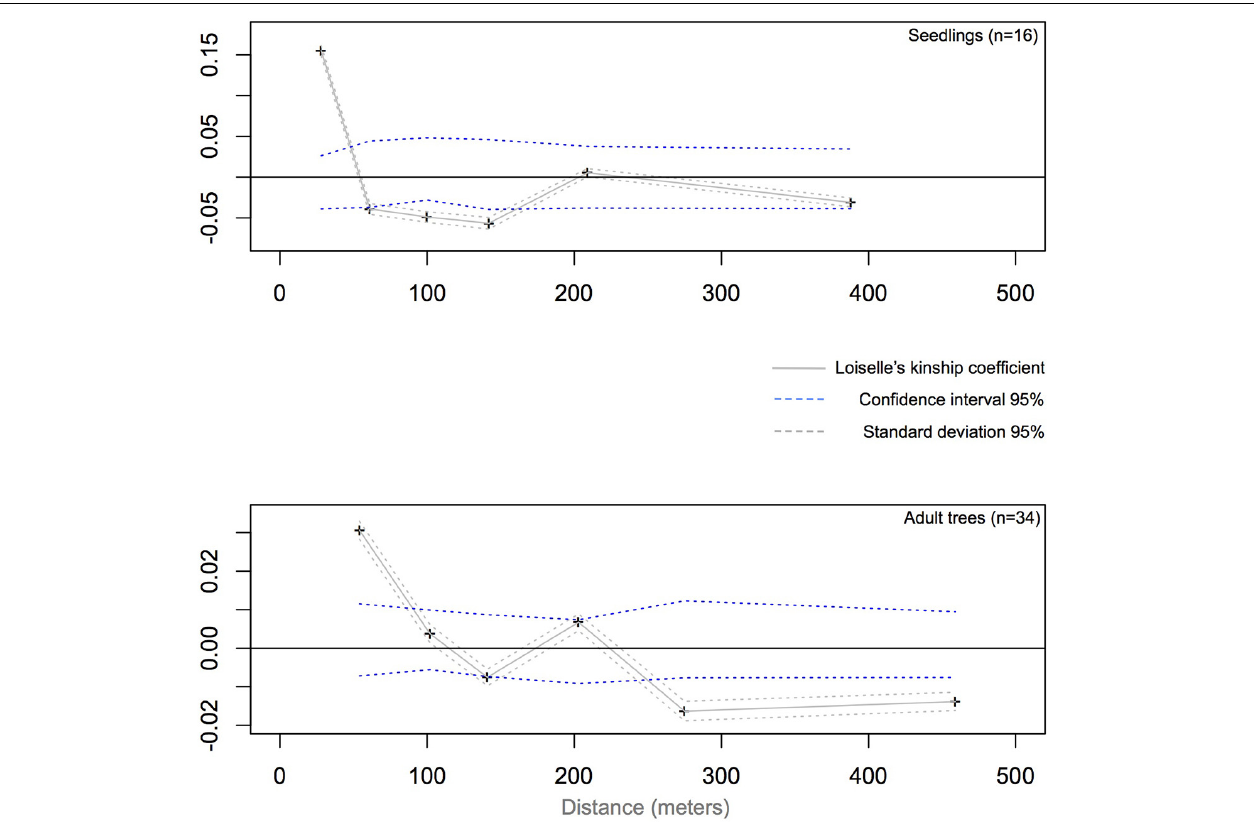
FIGURE 4 | Average Loiselle’s kinship coefficient ( F L ) plotted against geographical distance (in gray solid line) between seedlings (top plot) and adults (bottom plot) of Dinizia jueirana-facao. Individuals whose standard deviation of kinship coefficient lie outside the 95% CIs (blue dashed lines) are significantly more similar than would be expected through random sampling. For both reproductive trees and seedlings, a decrease in the kinship values was detected with increasing distances, with significant negative values indicating that distant individuals are not genetically related. The results are based on analyses of a data set generated with 5% MD and a 5% minor allele frequency